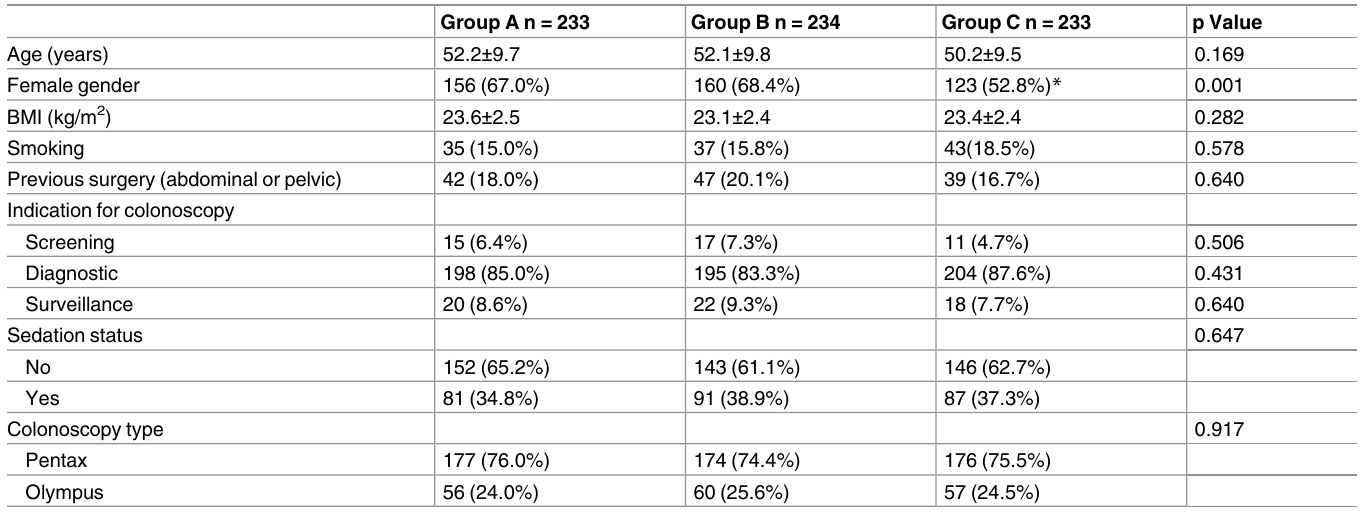
Table 1. Baseline characteristics of the study patients and colonoscopy.